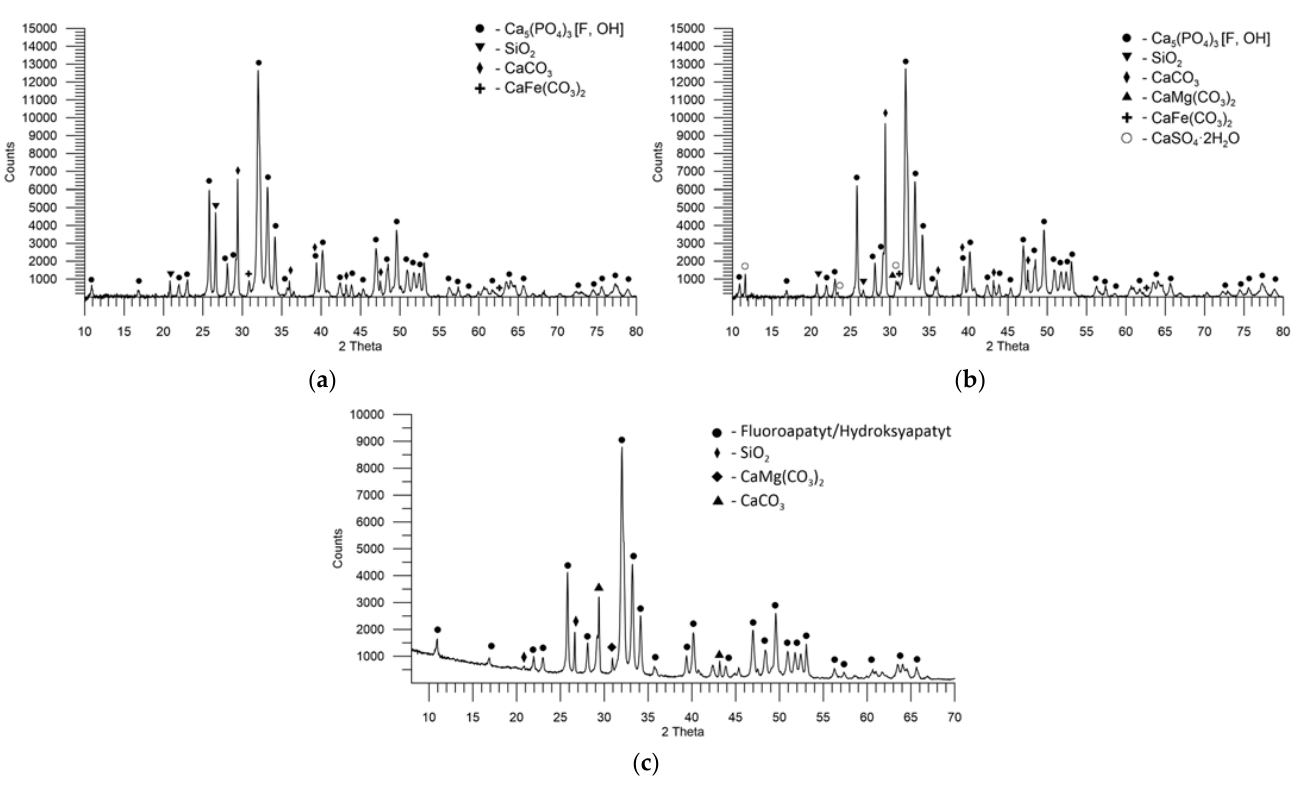
Figure 4. XRD pattern of PRs from various deposits: ( a ) PR1; ( b ) PR4.